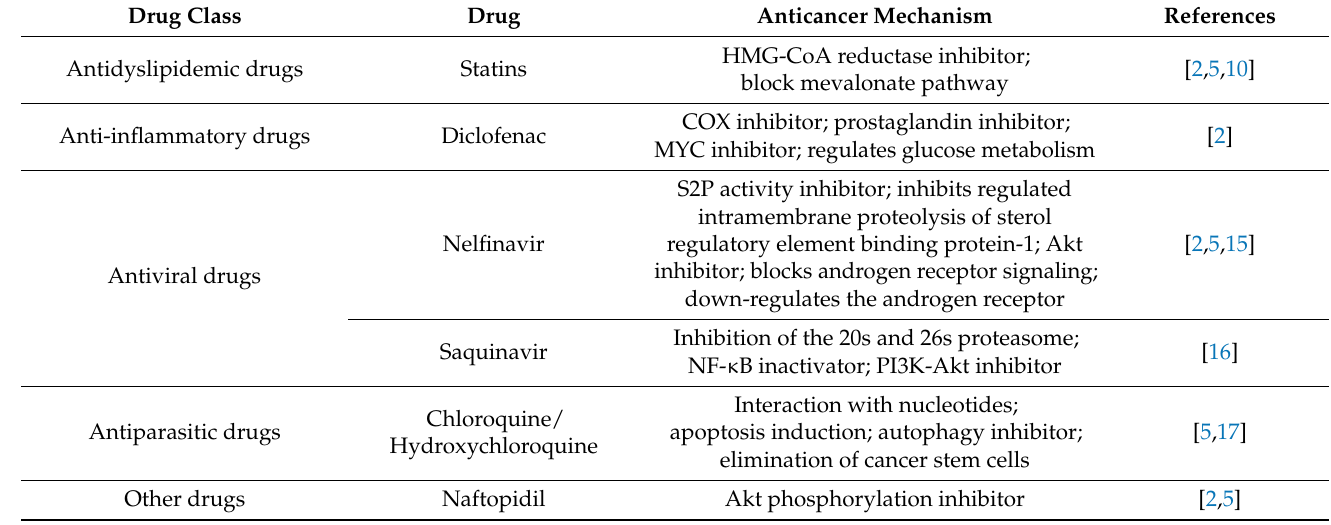
Table 1. Examples of radiosensitizer drugs that enhance the lethal effects of radiation and have anticancer